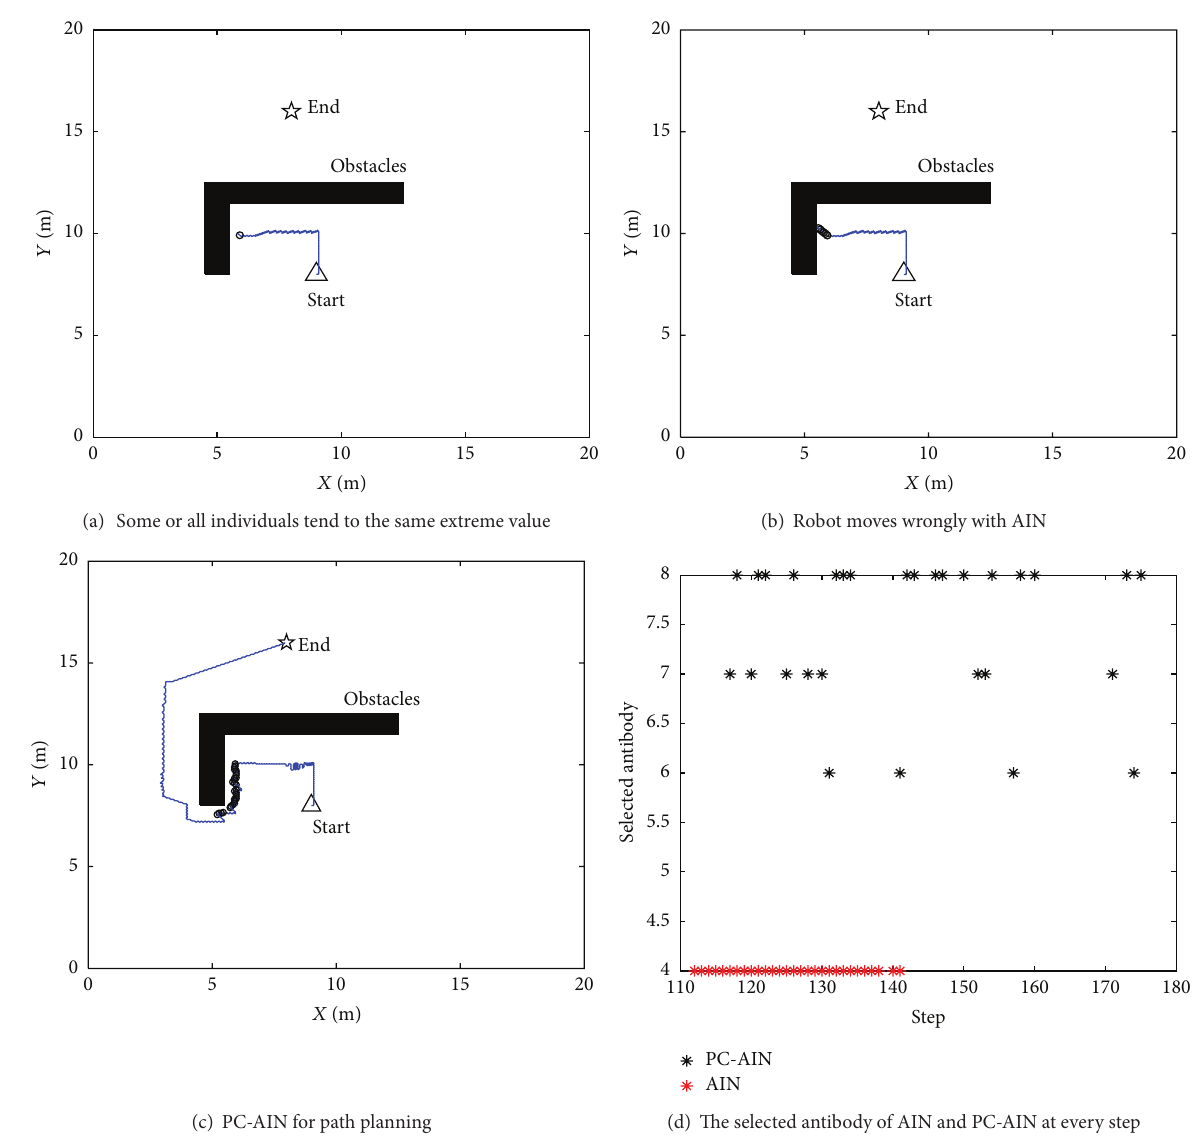
Figure 2: Mobile robot path planning with AIN and